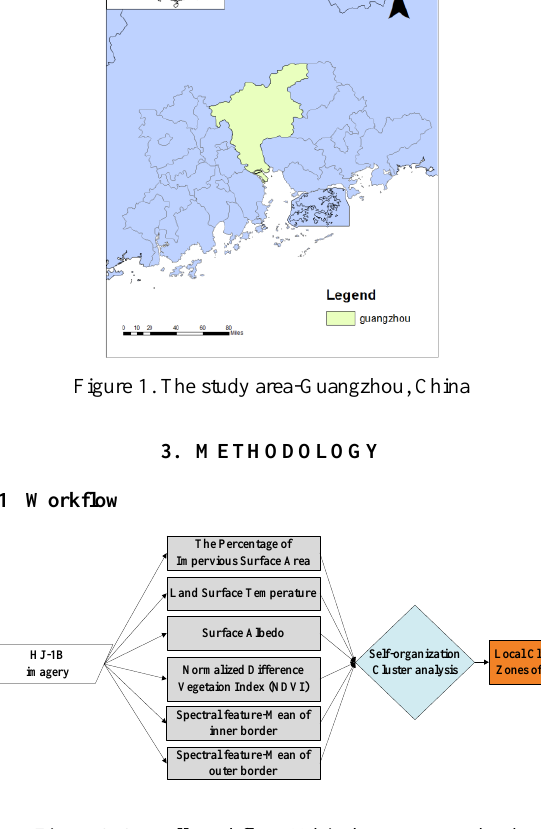
Figure 2. Overall workflow. White box presents the data sources, grey boxes represent the climate parameters, blue box represents the aggregation method, and original box represents